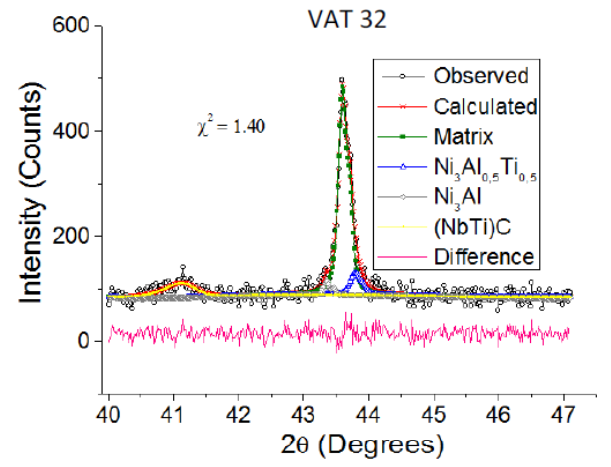
Figure 7. Rietveld refinement carried out in 40° ≤ 2θ ≤ 47° (VAT 32).